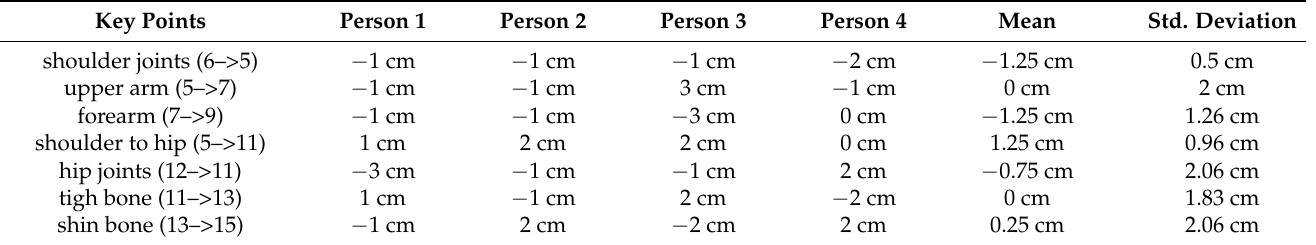
Table 3. Deviations of